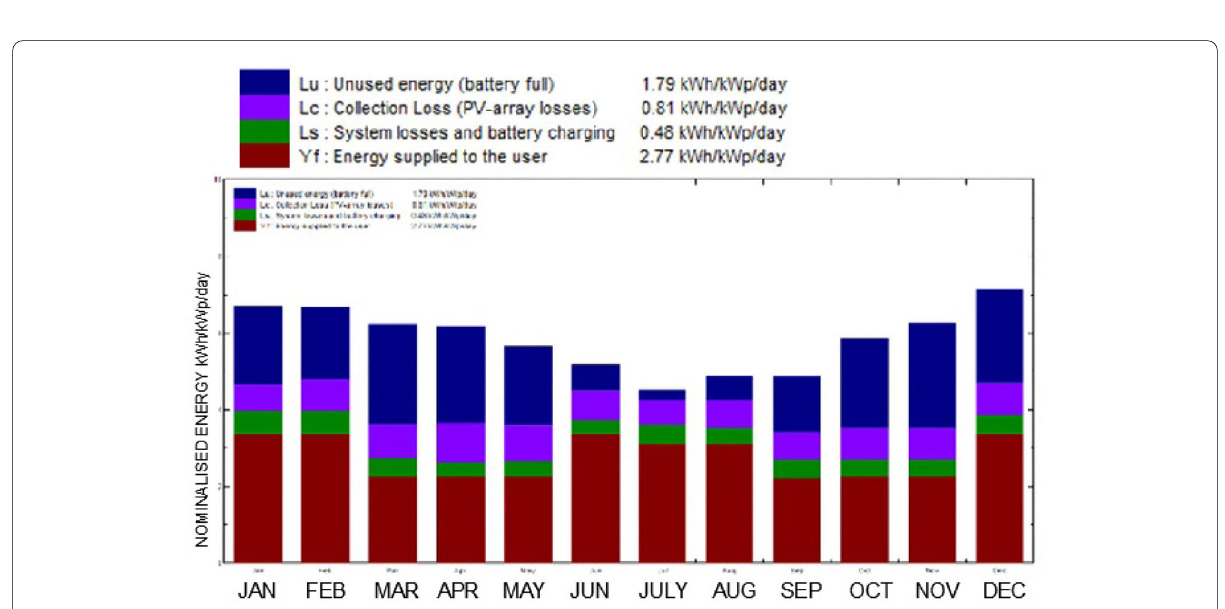
Fig. 8 Normalised energy production per installed kWp of the proposed PV